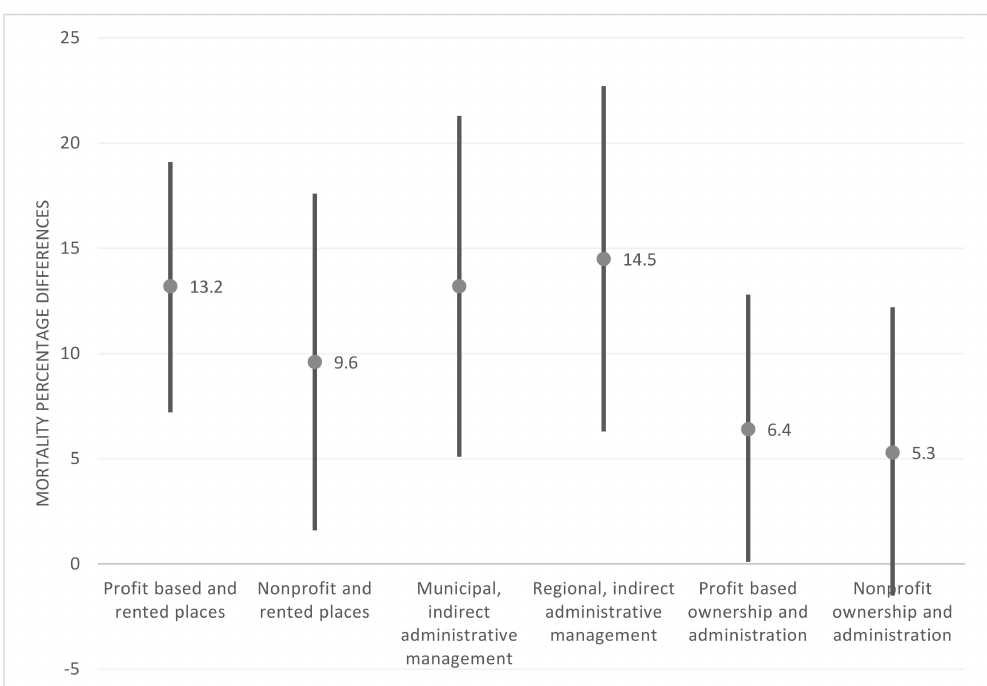
Figure 5. Mortality percentage differences between each LTCH type and the publicly owned and administered type, adjusted by size, location, spread of infection, and hospital clustering (95%